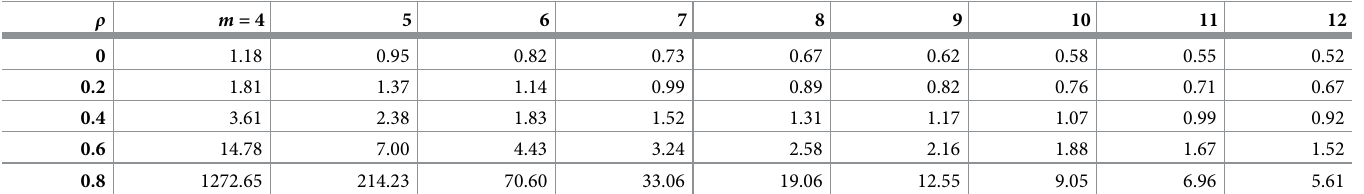
Table 1. Expected margins of error for 90% confidence intervals (95% one-sided confidence limit) for μ A−B from the paired serial t -test for level change in Eq 8; assumes σ 2 = 1.